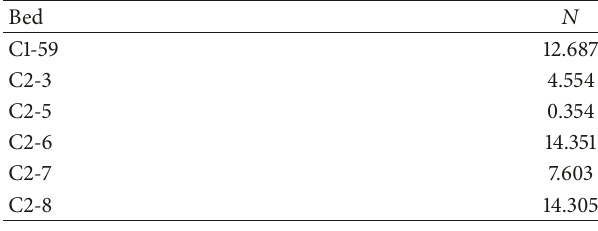
Table 1: Fracture intensity “ 𝑁 ” for each analysed bed.